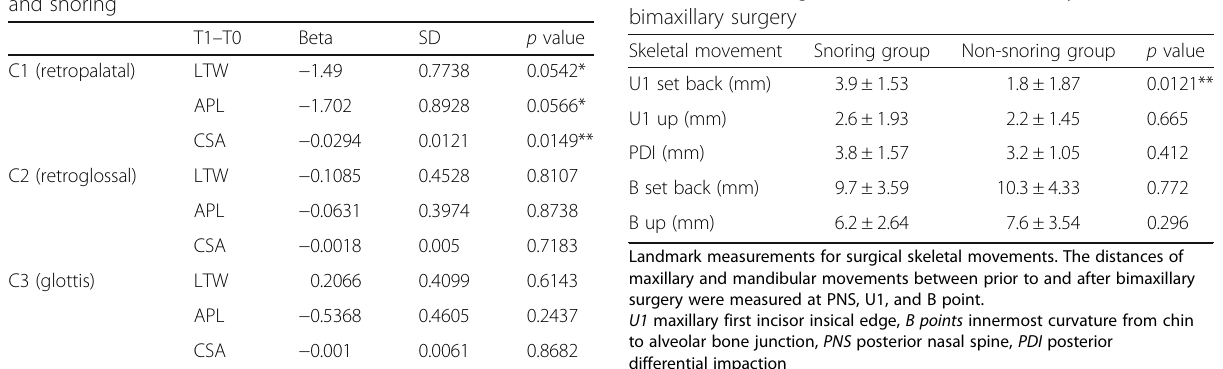
Table 6 The average skeletal movements of subjects